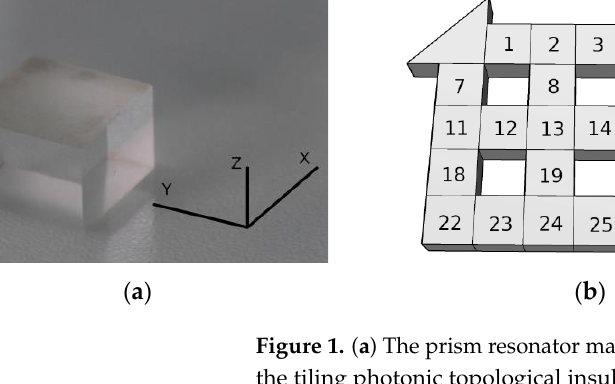
( b ) Figure 2. ( a ) The beam trajectory inside a smooth TPhTI model. ( b ) The corrected trajectory inside the TPhTI without prism resonator #3, as denoted in ( b ). The model shows that the light beam suc- cessfully bends around the defect of TPhTI. Figure 3 shows that the laser beam bypasses the defect and exits the triangular cou- pler. The beam trajectory passes along the surface of the TPhTI structure due to the effect of total internal reflection on the faces of the prism resonators and exits back, as evidenced